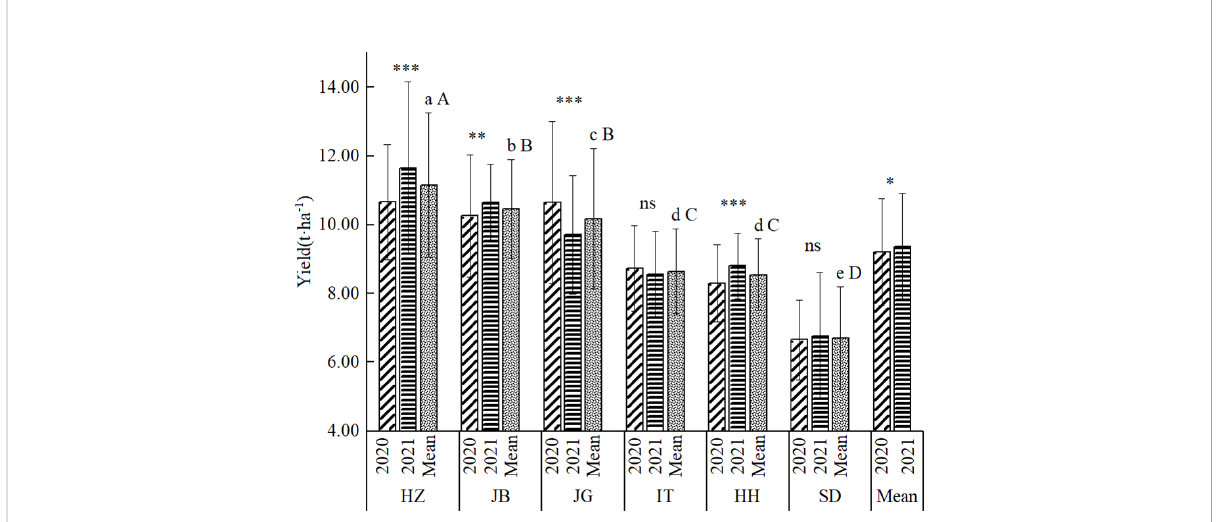
FIGURE 2 General yield performance at six locations in 2020-2021. a, b, c, d, c, e, (A – D) , indicating mean yield difference signi fi cance among locations at 0.05, and 0.01; *, ** and *** indicating difference signi fi cance between two years at 0.05, 0.01 and